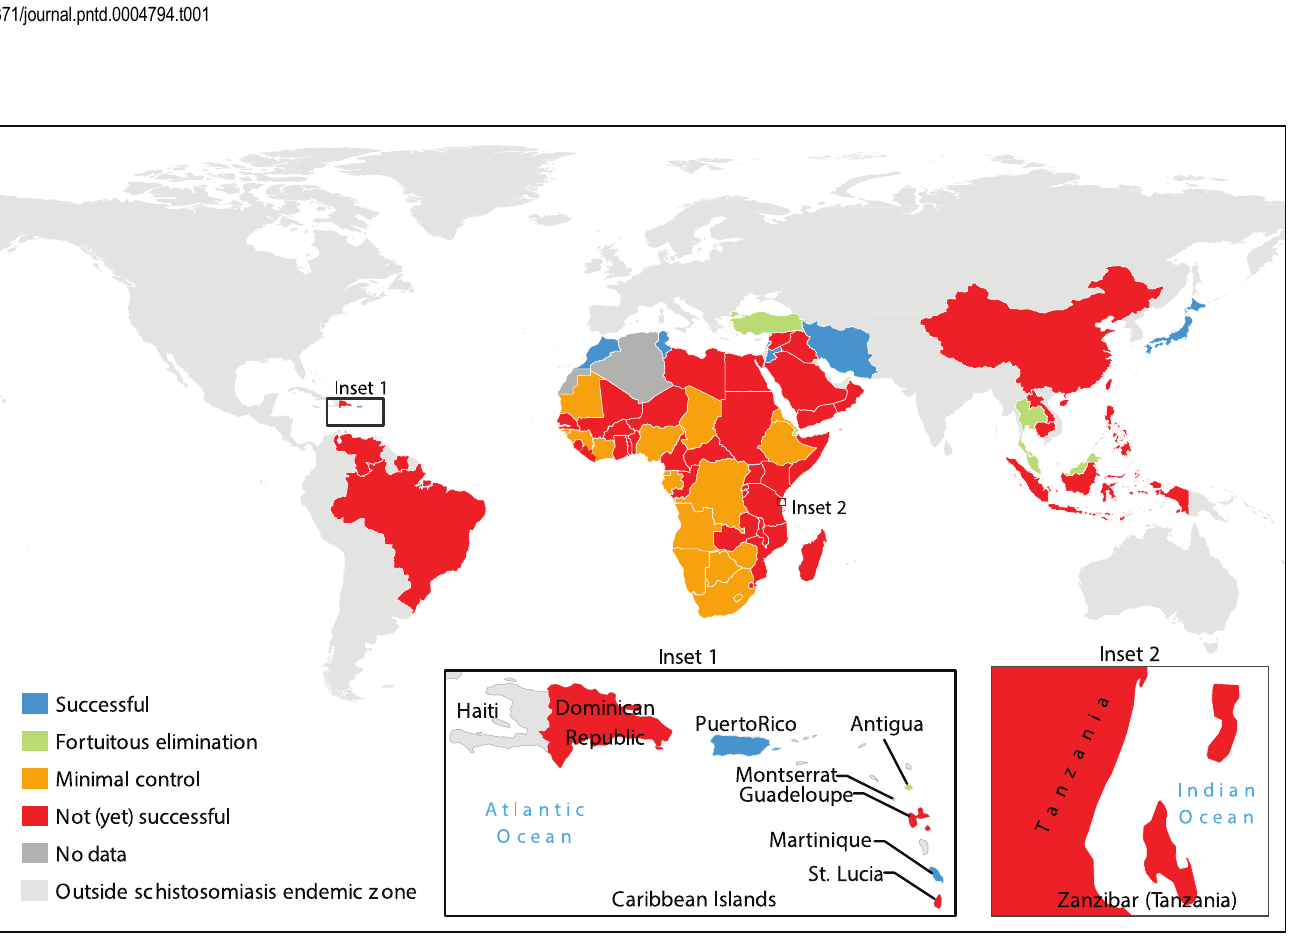
Fig 3. Countries and territories evaluated and their outcomes for schistosomiasis control or elimination. “ Successful ” = there was a control program that preceded elimination or non-endemic status; “ Fortuitous elimination ” = elimination or non-endemic status with no control program; “ Minimal control ” = endemic disease in the face of minimal to no control, even if there were some pilot or small-scale programs; “ Not (yet) successful ” = endemic disease with a past or present control